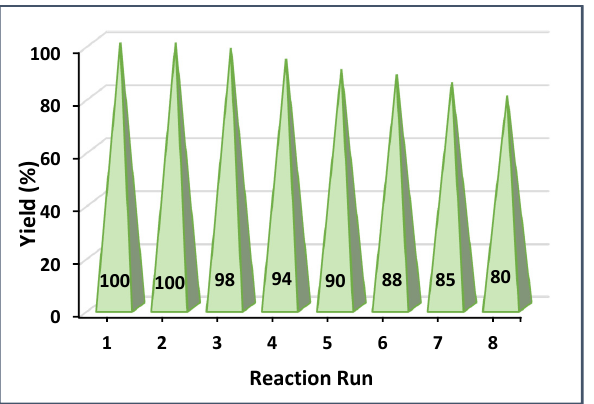
Figure 11. Reusability of Hal-Py-IL for the preparation of 4 H -benzo[ b ] pyrans for the reaction of 4-nitrobenzaldehyde, malononitrile, dimedone at 50 °C in EtOH. The reused Hal-Py-IL after eight runs was analyzed via FTIR spectroscopy and the recorded FTIR spectrum was compared with spectrum of fresh Hal-Py-IL. As depicted in Figure 12, FTIR spectrum of the reused Hal-Py-IL is identical to that of the fresh one and contains all of the absorbance bands of the fresh catalyst, implying that reusing of Hal-Py- IL did not induce structural collapse and Hal-Py-IL was stable in the course of recycling. Figure 12. The FTIR spectra of fresh and reused Hal-Py-IL after eight runs. 3. Materials and Methods The used reagents and solvents for the preparation of the catalyst included Hal, 3- (aminpropyl)-triethoxysilane (APTES), 2-aminopyrimidine, 1,4-butanesultone, potassium carbonate (K 2 CO 3 ), 2,4,6-trichloro-1,3,5-triazine (TCT), tetrahydrofuran (THF), toluene, all was purchased from Sigma-Aldrich. The chemicals that have been applied for the evalu- ation of the catalytic performance of the catalyst included dimedone, malononitrile, etha- nol (EtOH), aldehydes. All was received from Sigma-Aldrich (Germany, Taufkirchen). In order to confirm the formation of the designed catalyst, several analyses, includ- ing, thermo gravimetric analysis (TGA), X-ray diffraction (XRD), scanning electron micro- scope (SEM), Fourier transform infrared (FTIR), energy dispersive spectroscopy (EDS) and elemental mapping analyses were conducted. The technical data of the applied appa- ratuses are as follow: BRUKER TENSOR 35 (Germany, Berlin) was used for performing FTIR spectroscopies using KBr pellet. Using METTLER TOLEDO thermogravimetric anal- ysis instrument (model Leicester, Leicester, UK) with heating rate of 10 °C/min, the TG analyses were carried out under N 2 atmosphere. Siemens, D5000 instrument (Karlsruhe,